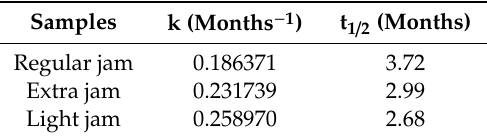
Table 3. Rate of degradation of anthocyanins (k) and time of half-life of anthocyanins (t 1 / 2 ) in the regular, extra and light tart cherry jams after